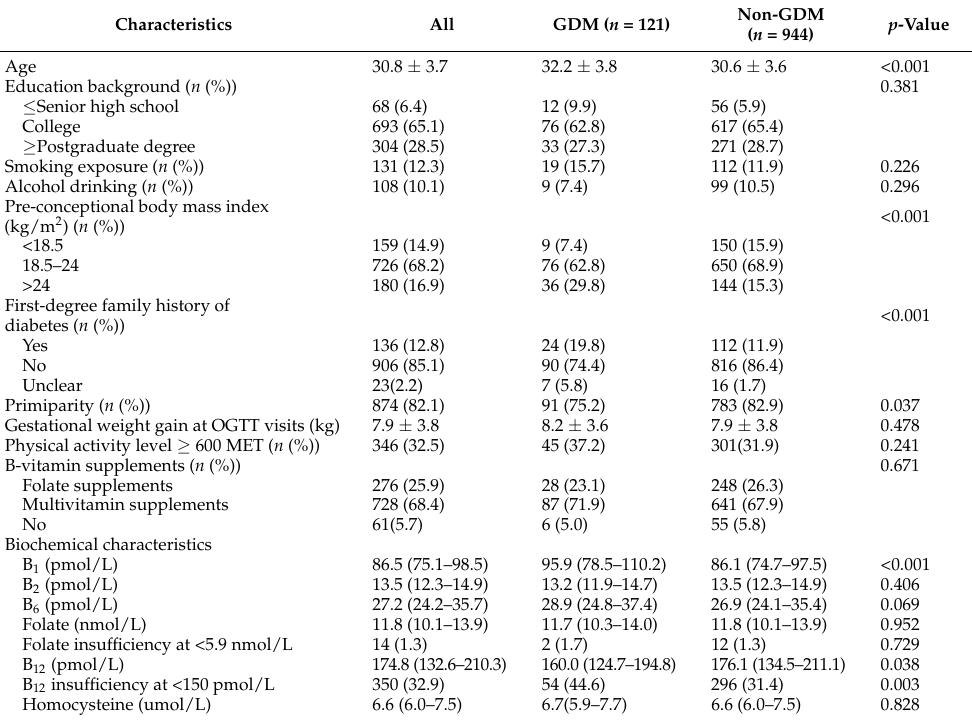
Table 1. The basic characteristic of the study population by gestational diabetes mellitus (GDM) status (N =